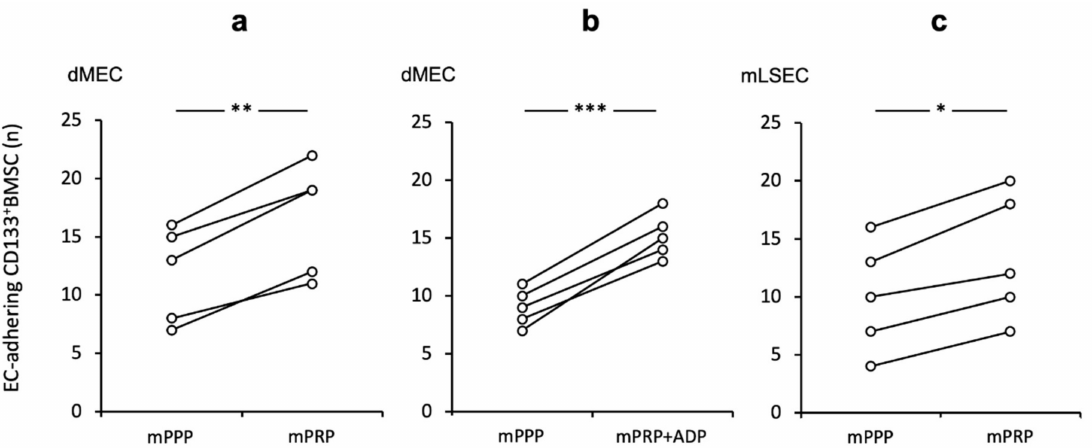
Figure 2. Augmented CD133 + BMSC adherence to endothelium subsequent to platelet co-incubation in a murine shear-stress model Adherence of CD133 + BMSC to murine endothelial cells co-incubated with mouse platelet rich plasma (mPRP) was tested by pairs under di ff erent conditions: control and treatment at a time. ( a ) Significant increase in adhering mouse CD133 + BMSC to mouse dermal micro-endothelial cells (dMEC) with mPRP when contrasted to mPPP (mouse platelet poor plasma). ( b ) Platelet activation by ADP did not further enhance the mPRP e ff ect. ( c ) Augmenting platelet e ff ect on mCD133 + BMSC adhesion to mLSEC. Experiments were performed at shear levels of 1.0 dyne / cm 2 followed by quantification of adherent CD133 + BMSC in % of mPPP control conditions. Paired t -test: * p < 0.05; ** p < 0.01; *** p <